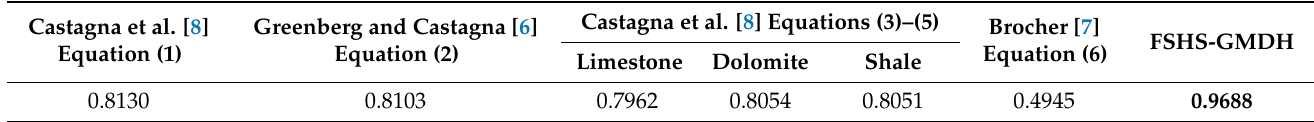
Table 2. Statistical analysis (R 2 ) of shear wave velocity estimation calculated by experimental methods Equations (1)–(6).